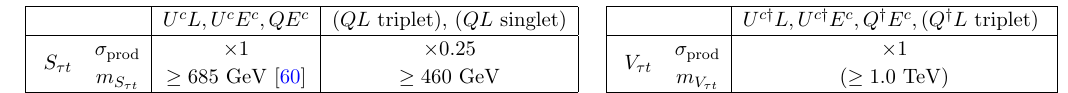
Table 11 . 95% CL lower limits on the mass for various MLQs which decay into ( (cid:28)t )( (cid:28)t ) (cid:12)nal states for scalar LQs ( left ) and vector LQs ( right